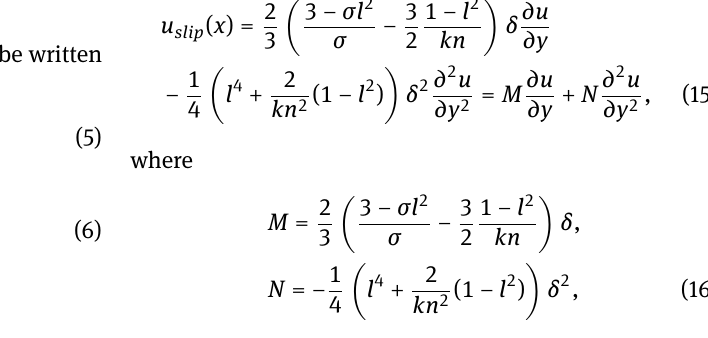
Figure 1: Schematic diagram of the physical model and the typical patterns of boundary